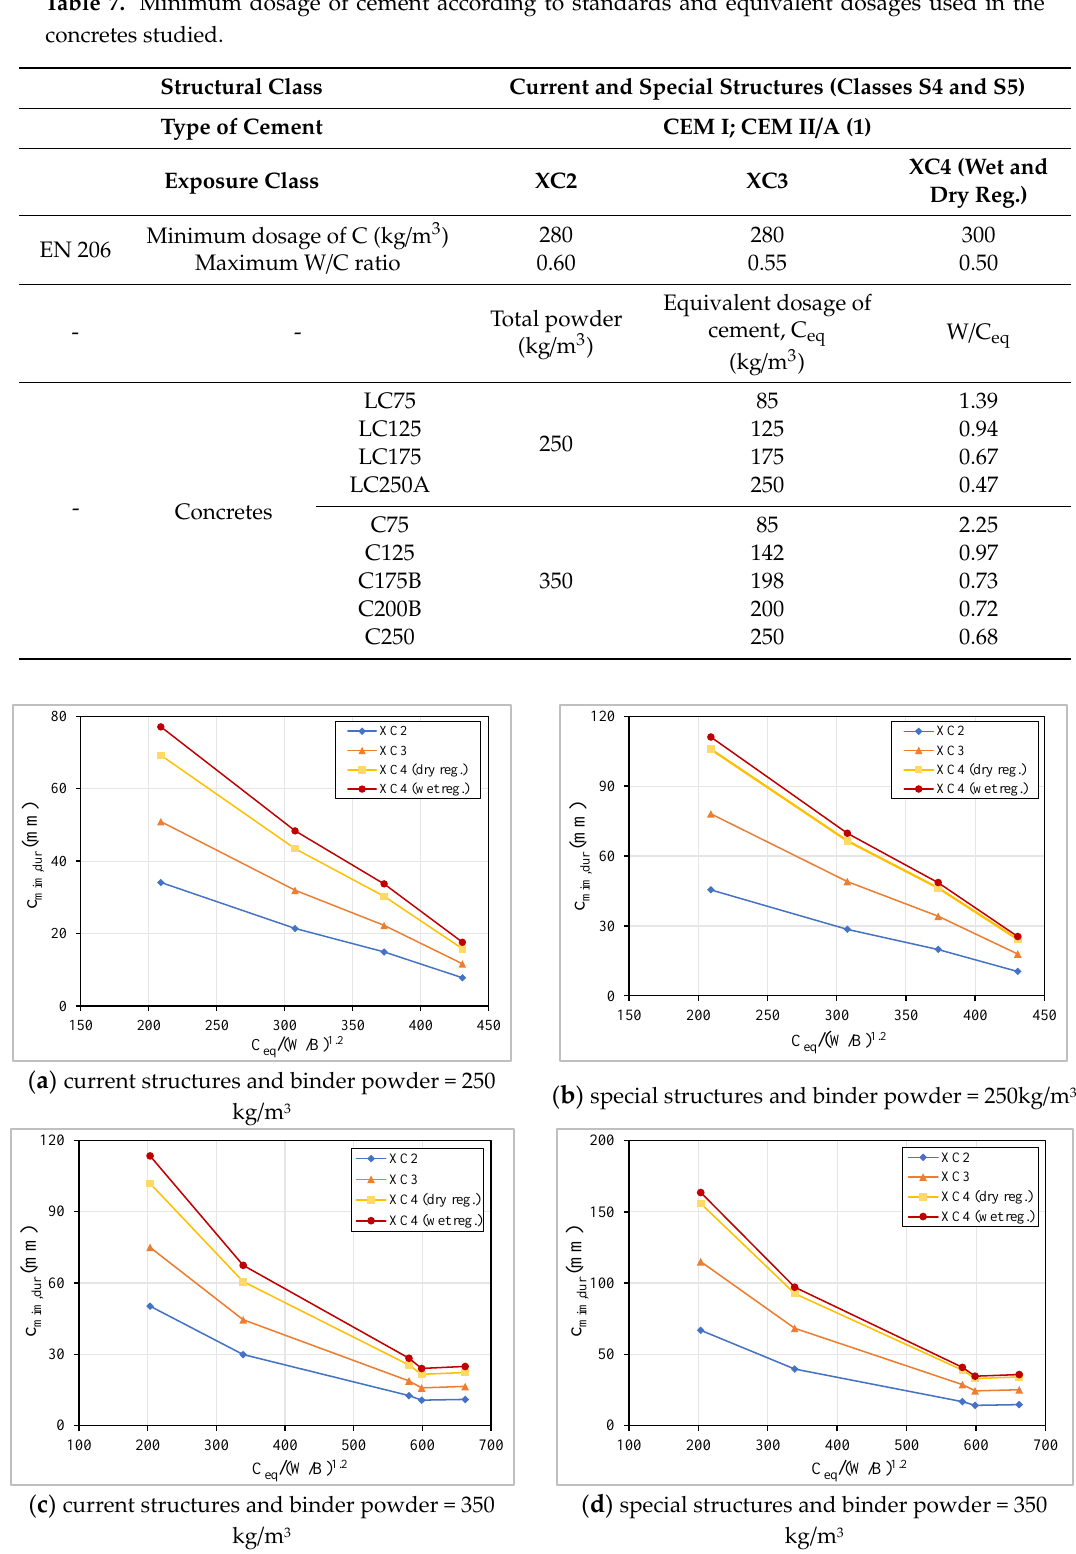
Table 7. Minimum dosage of cement according to standards and equivalent dosages used in the concretes studied.